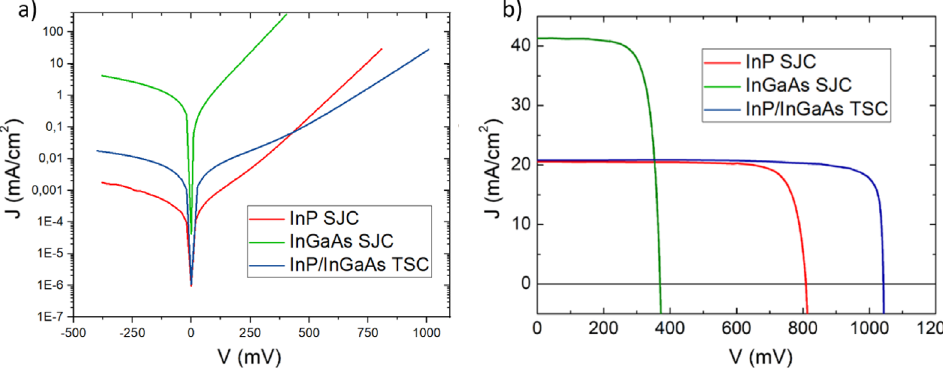
Fig. 3. (a) J – V characteristics under dark conditions of the obtained InP/InGaAs tandem cell (blue line) compared to the single J – V characteristics of InP top cell (red line) and InGaAs bottom cell (green line). (b) J – V characteristics under 1-sun illumination of the obtained InP/InGaAs tandem cell (blue line) compared to the single J – V characteristics of InP top cell (red line) and InGaAs bottom cell (green line).